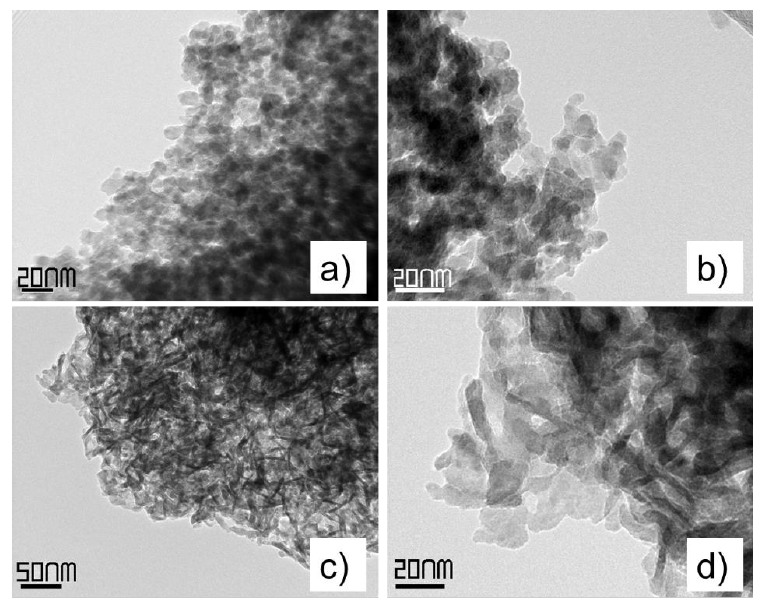
Figure 4. Transmission electron microscopy (TEM) images of: ( a , b ) CuO/ZnO/Al 2 O 3 catalyst prepared via oxalate gel-co-precipitation; ( c , d ) CuO/ZnO/Al 2 O 3 catalysts prepared via Na 2 CO 3 co-precipitation. Cu/Zn/Al (molar) = 35/35/30.